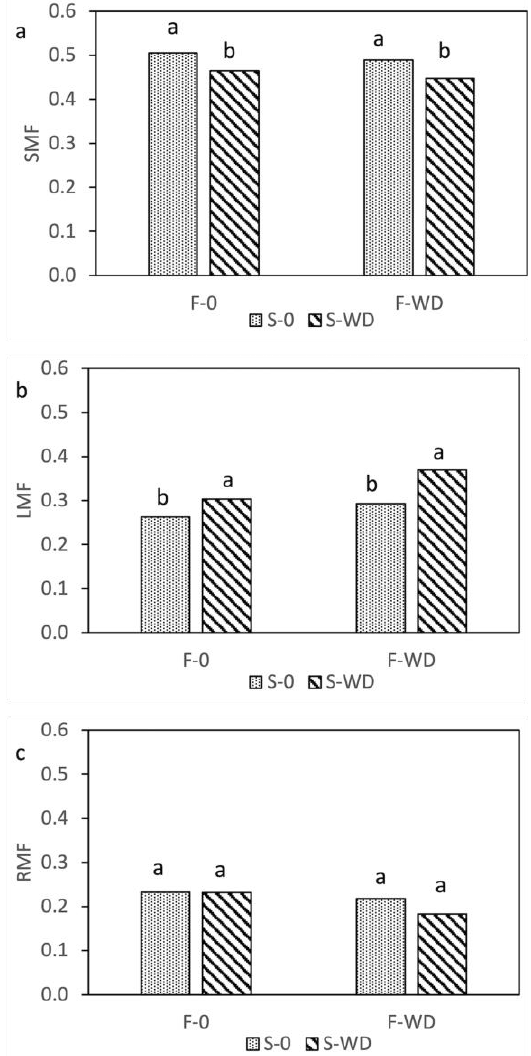
Figure 1. Stem (( a ), SMF), leaf (( b ), LMF), and reproductive (( c ), RMF) mass fractions of field bean, as affected by the interaction of wood distillate (WD) distribution as foliar spray (F) or soil irrigation (S). Data are means of three replicates. For each parameter, columns with the same letter indicate not significantly different means at p ≤ 0.05, Tukey test.